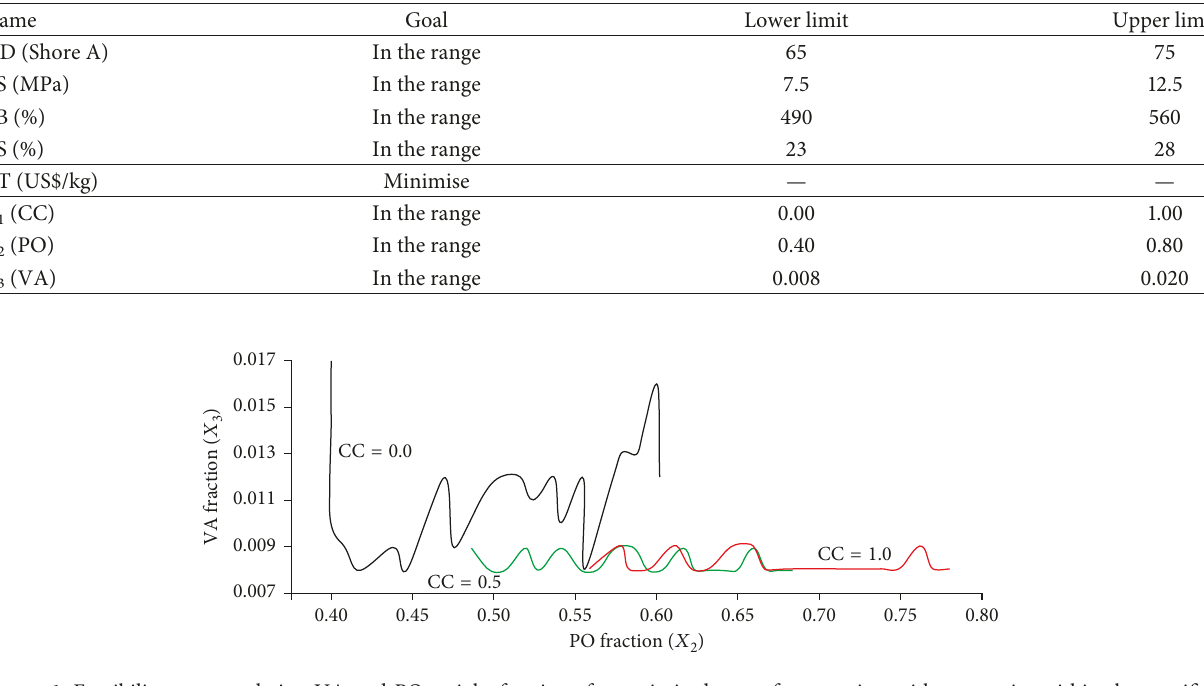
Figure 1: Feasibility curves relating VA and PO weight fractions for optimised cost of composites with properties within the specified ranges, when the CC weight fraction is kept constant at 1.0, 0.5, and 0.0. Table 8: Examples of optimised mixture compositions and predicted values of the corresponding properties. Mixture point